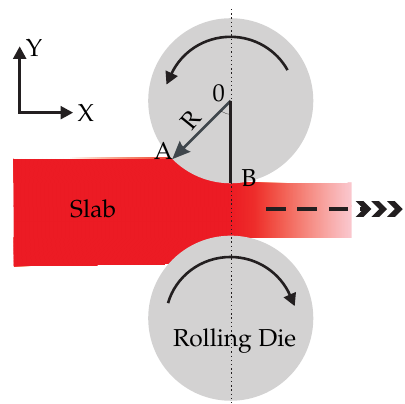
Figure 1. Geometrical relation between rolling die and flat rolling